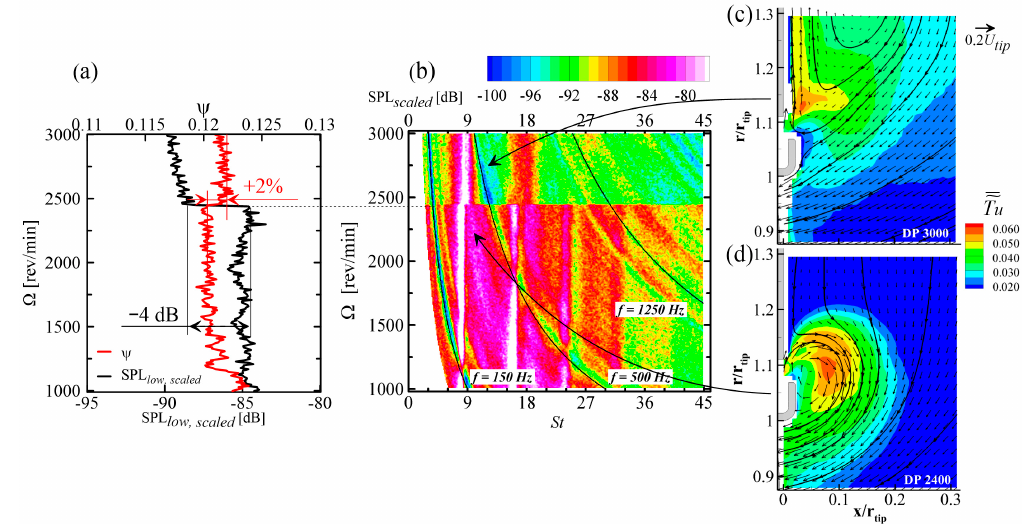
Figure 3. Measurements on a plastic rotor. ( a ) SPL low,scaled and Ψ during a Ω ramp; ( b ) sound pressure level (SPL) spectrogram during a speed ramp; ( c ) time-mean velocity field at 3000 rev / min; ( d ) time-mean velocity field at 2400 rev / min. (Adapted from Canepa et al. [11]).